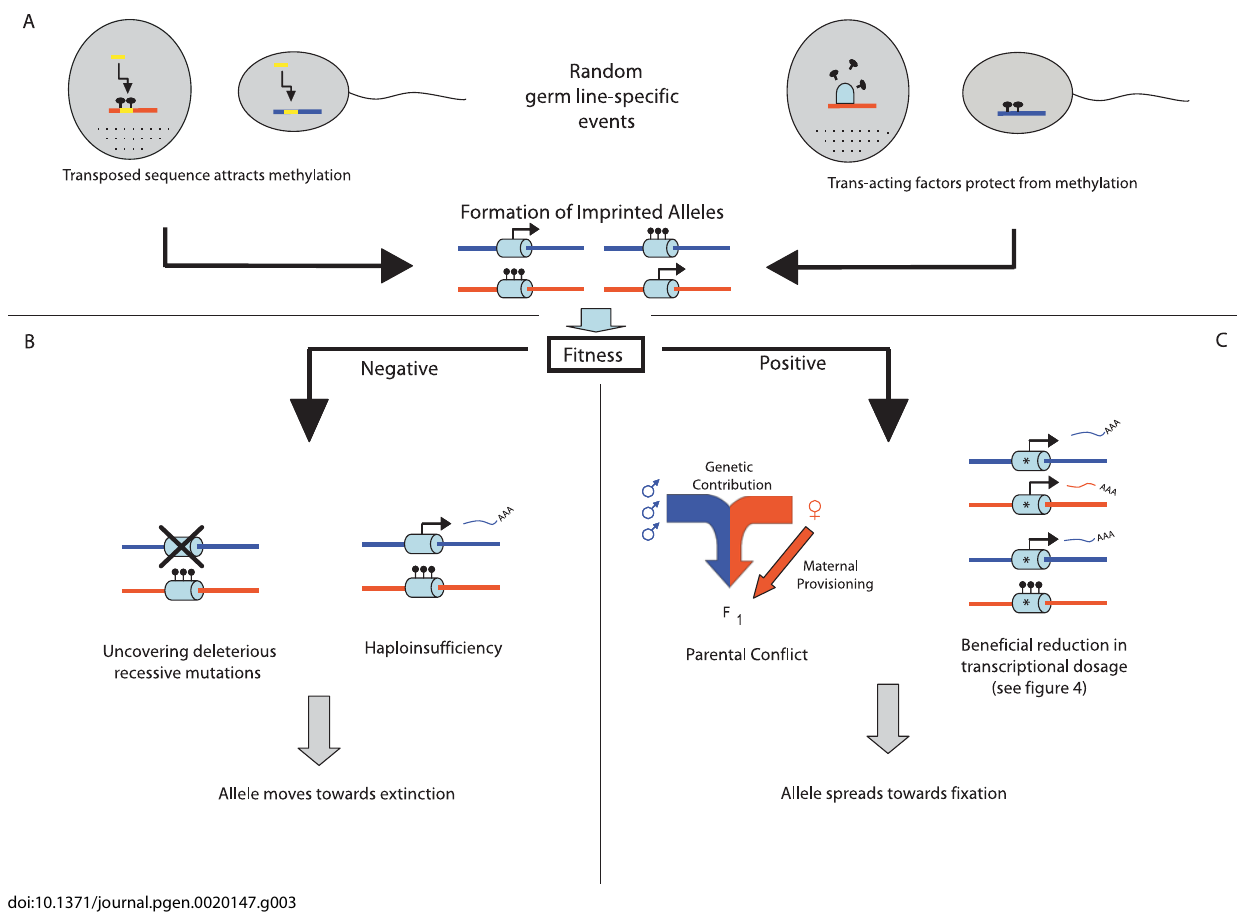
Figure 3. Overview of the Evolution of Imprinted Loci Blue represents paternal or paternally derived alleles, red represents maternal or maternally derived alleles, and yellow represents transposed sequence. Black lollipops represent methylated CpGs, and the light blue dome represents a trans -acting factor. An asterisk denotes a gene duplicate. (A) Random molecular events or mutations in the germ-cell lineage generate alleles that undergo differential methylation when passing through the male and female germ line, which can confer either (B) negative or (C) positive fitness. While most of these alleles would be expected to confer negative fitness (B), a small proportion are maintained (C). Possible reasons for the spread of these alleles (C) are discussed further in the text and in Figure 4, which are by no means intended to be exhaustive. F1, first filial generation.